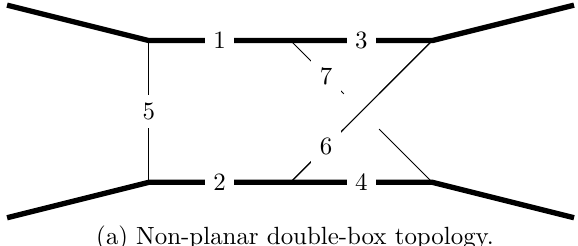
Figure 15. Top-level topologies at two-loops. Indices correspond to the propagators listed in eq.